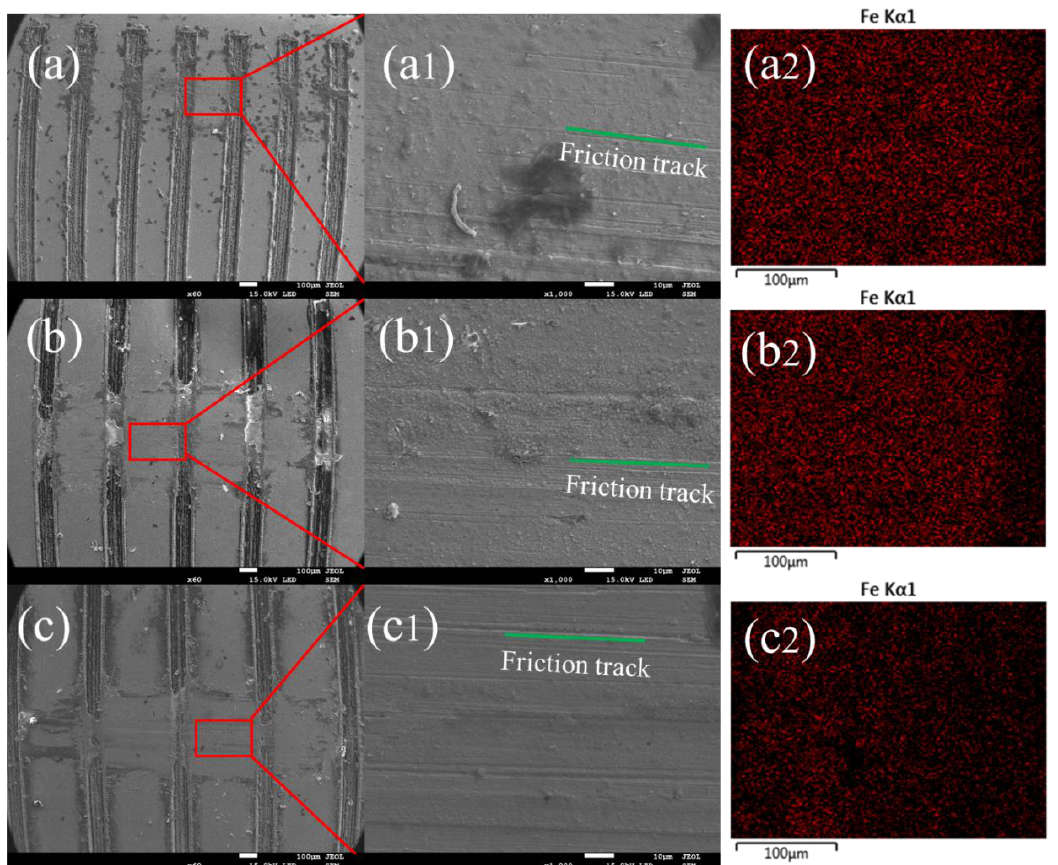
Figure 9. Elemental mapping of Fe on the worn surfaces of Fe-Zn samples (T0.3-W0.1-N2-Fe group). ( a ) The sample with a center distance of 0.3 µ m. ( b ) The sample with a center distance of 0.4 µ m. ( c ) The sample with a center distance of 0.5 µ m. ( a1 ) Partial enlargement of a-graph. ( b1 ) Partial enlargement of a-graph. ( c1 ) Partial enlargement of c-graph. ( a2 , b2 , c2 ) Iron contents different friction surfaces.